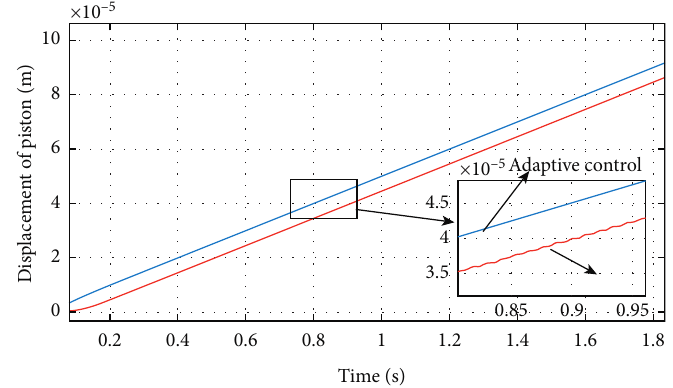
Figure 5: Piston